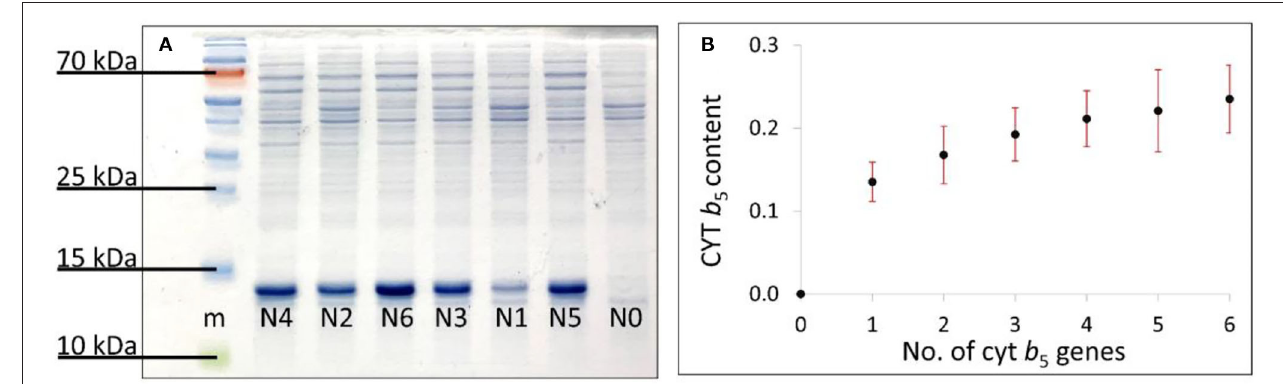
FIGURE 5 | (A) UV-vis spectra of bacterial lysates of a strain N6 with 0–100 µ M hemin supplementation showing an increase in the Soret absorption peak as indicated by a black arrow. (B) A plot of the Soret absorption of TE buffer (blank) and bacterial strains N0–N6 with hemin supplementation. (C) A plot of an average absorbance at a Soret peak representing Cyt b 5 content from 7 biological replicates against numbers of cyt b 5 genes. SDs are shown as red bars.